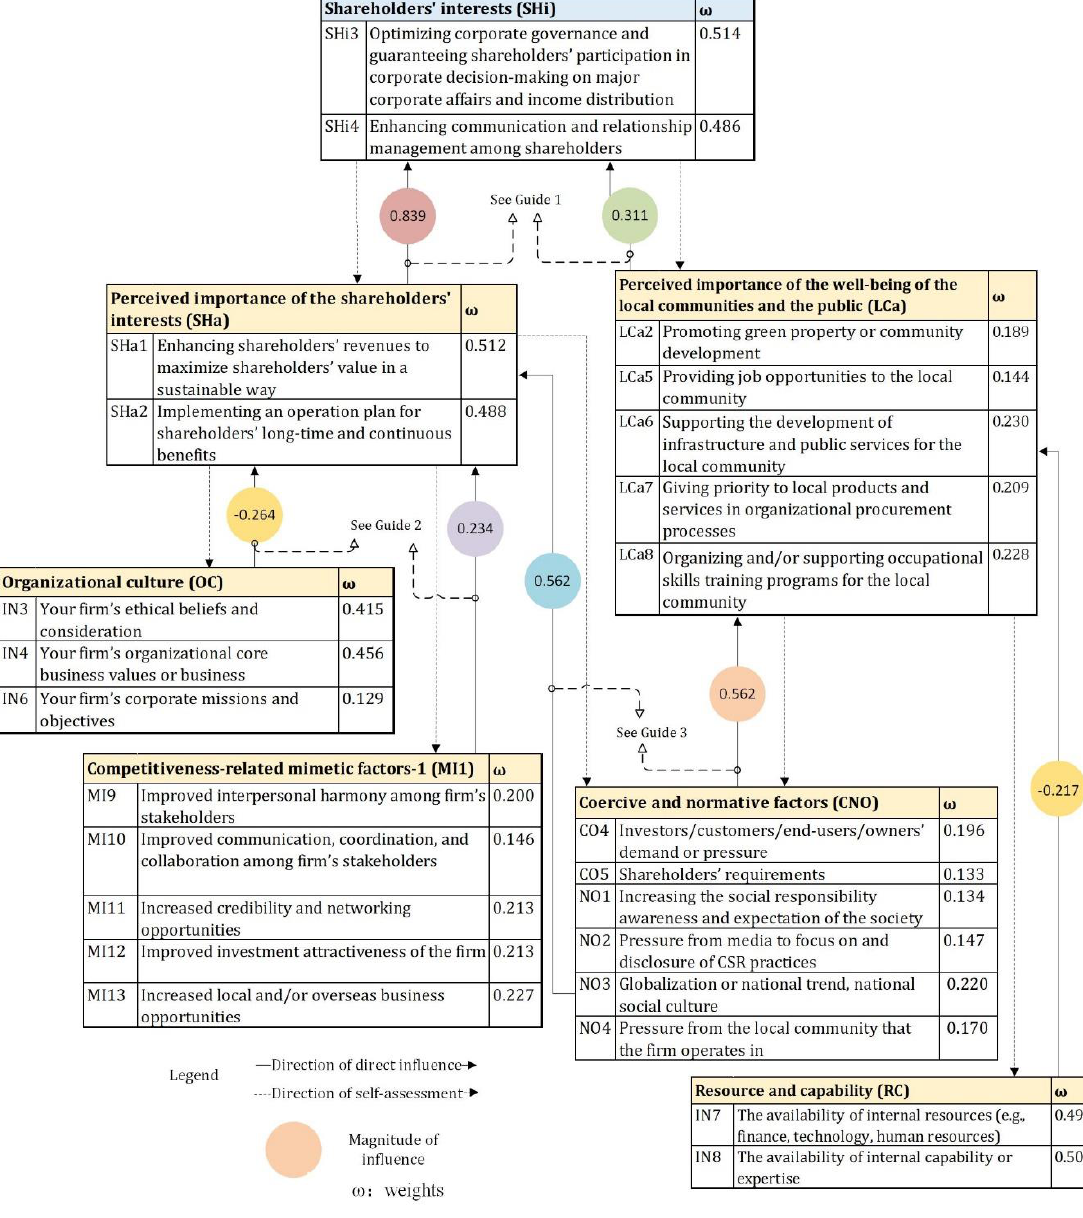
Figure 3. Checklist for firms’ CSR implementation regarding the shareholders’ interests (SHi) .